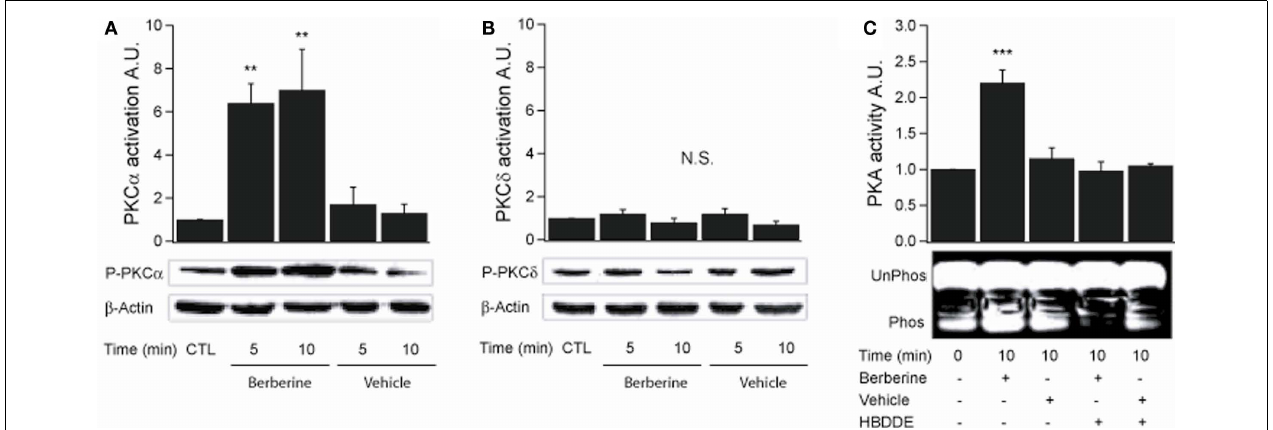
FIGURE 4 | Berberine effect on PKC isoforms and PKA activity inT84 cells. (A) Representative blot of PKC α phosphorylation levels at Ser 657 in cellular extracts fromT84 cells after berberine treatment (300 μ M) for 5 and 10min compared to vehicle controls. (B) Representative blot of PKC δ phosphorylation levels at Ser 643 in cellular extracts fromT84 after berberine treatment (300 μ M) cells for 5 and 10min compared to vehicle controls. Beta-actin was used as an internal control for protein loading.The graphs